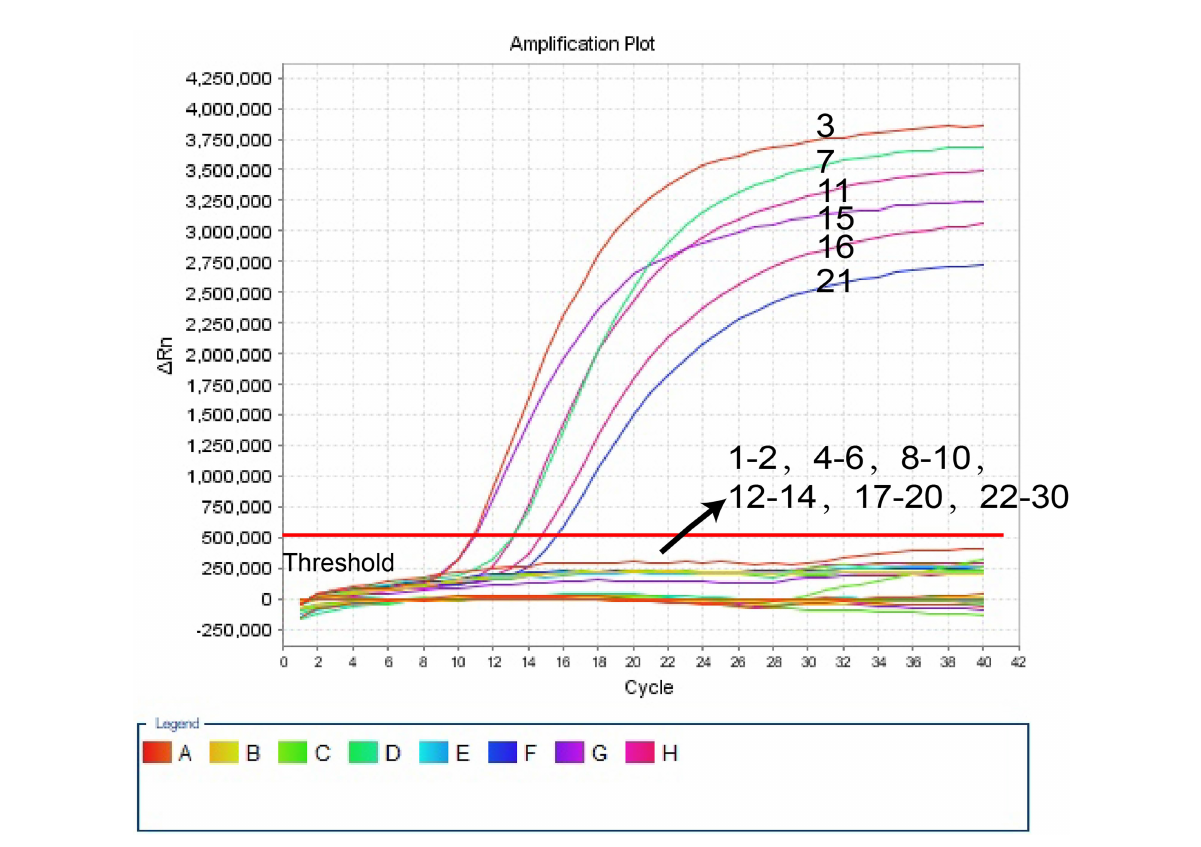
FIGURE 5 The H. influenzae- ERT-LAMP assay for detecting H. influenzae in clinical samples. Signals 3, 7, 11, 15, 16, 21 indicate H. influenzae in clinical samples in FAM channels. Signals 1–2, 4–6, 8–10, 12–14, 17–20, 22–30 represented the negative